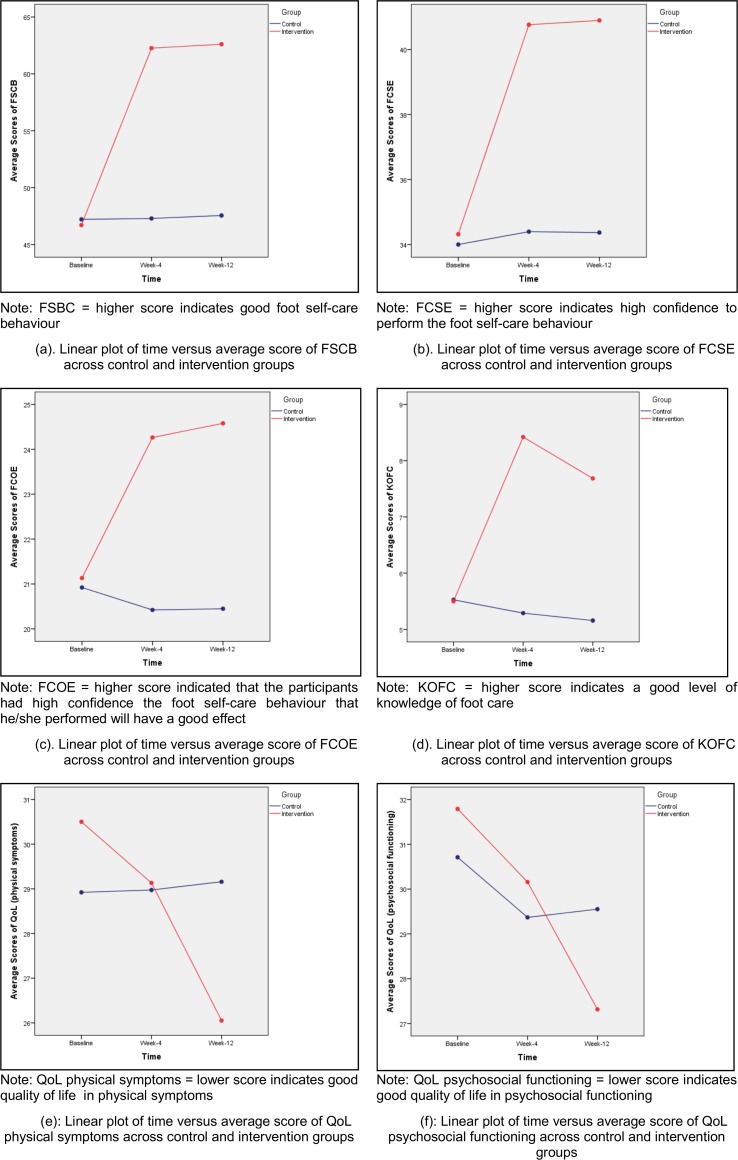
(a)—(f). The linear plot of the time effects for each variable across two groups.